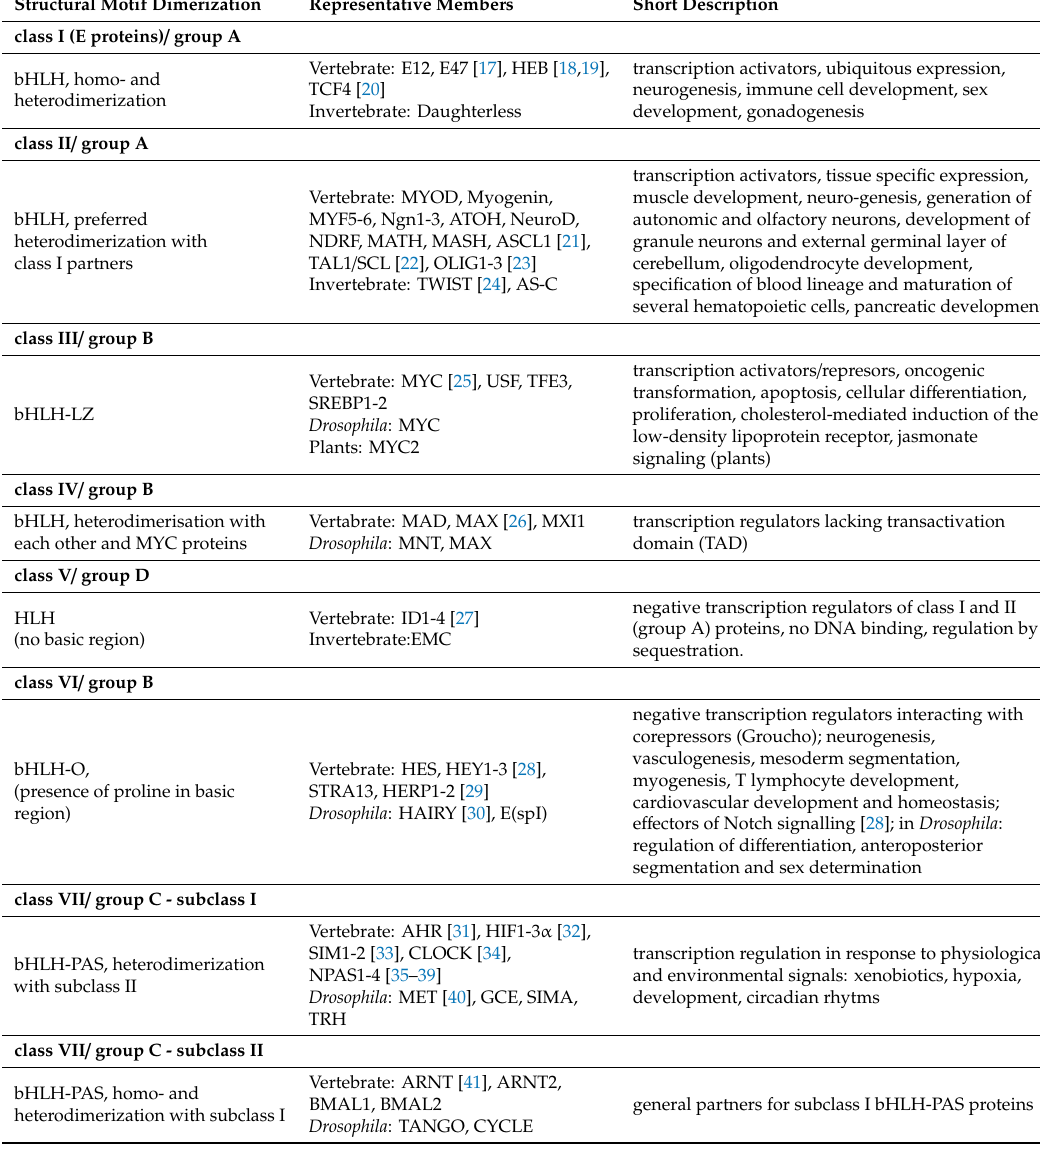
Table 1. Classification of bHLH proteins based on